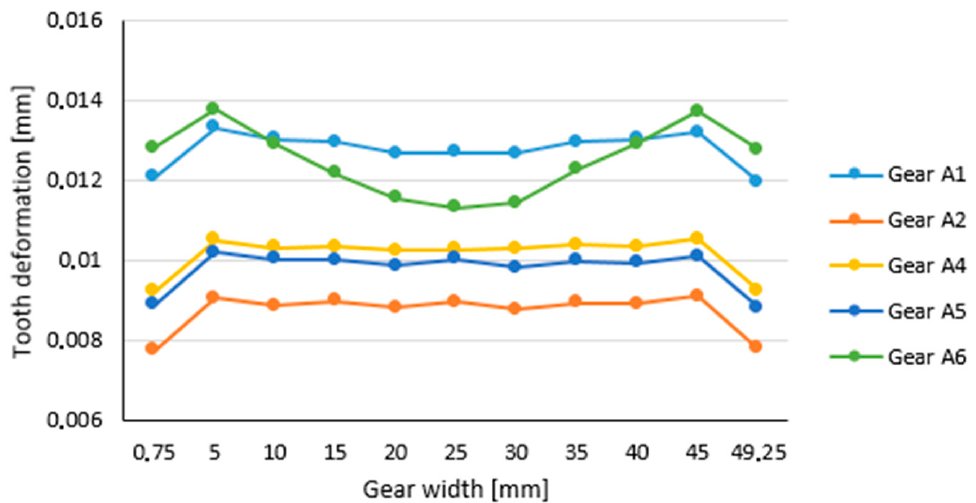
Figure 6. Comparison of tooth deformation along the width of the forged gear wheel for individual models.